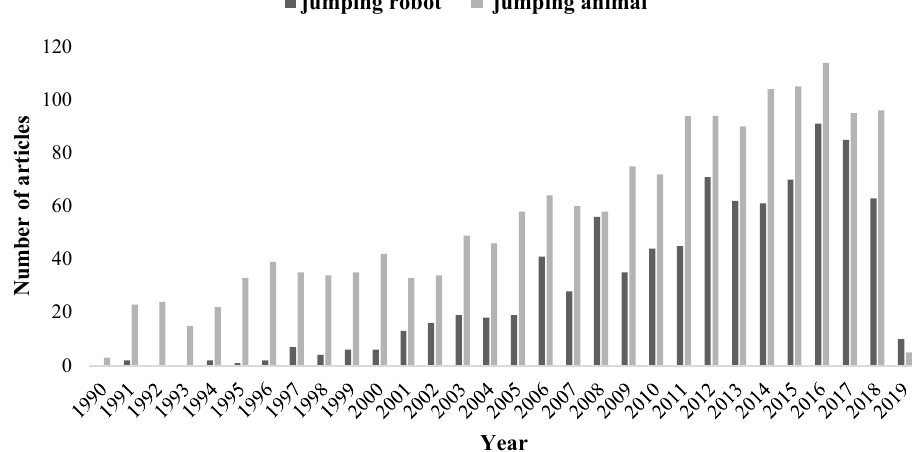
Figure 1. Number of published research items per year (1990–2019, until 20 February 2019) focusing on jumping animals and robots.